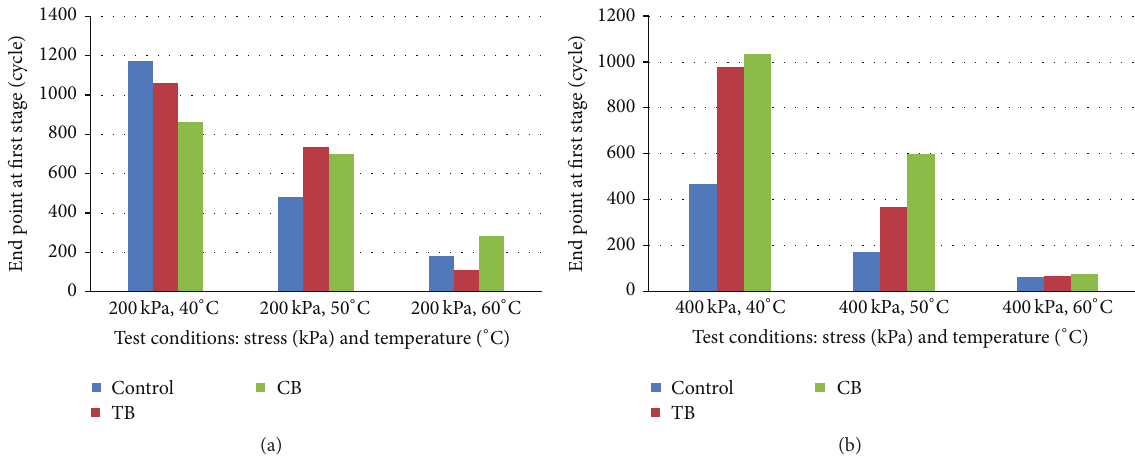
Figure 6: (a) End point at first stage for control and rubberized asphalt mixtures at different temperatures tested at 200 kPa. (b) End point at first stage for control and rubberized asphalt mixtures at different temperatures tested at 400 kPa.